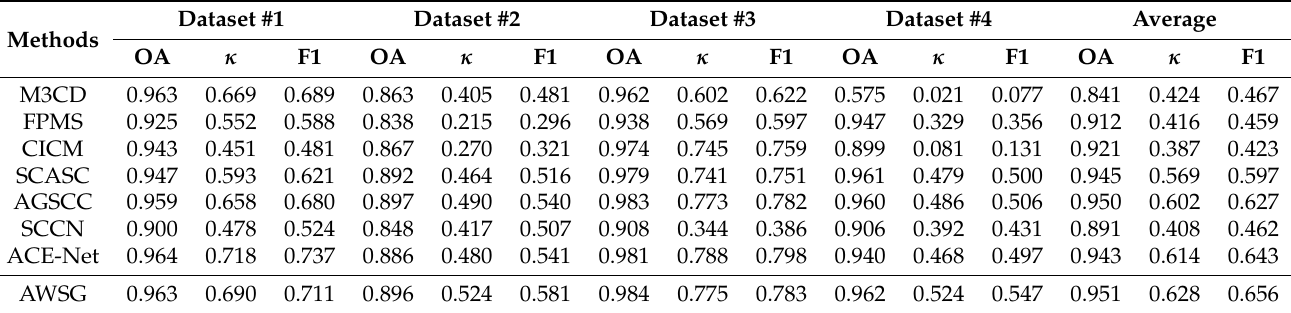
Table 2. Quantitative measures of binary CMs on the heterogeneous datasets. Note that SCCN and ACE-Net are deep-learning-based methods.